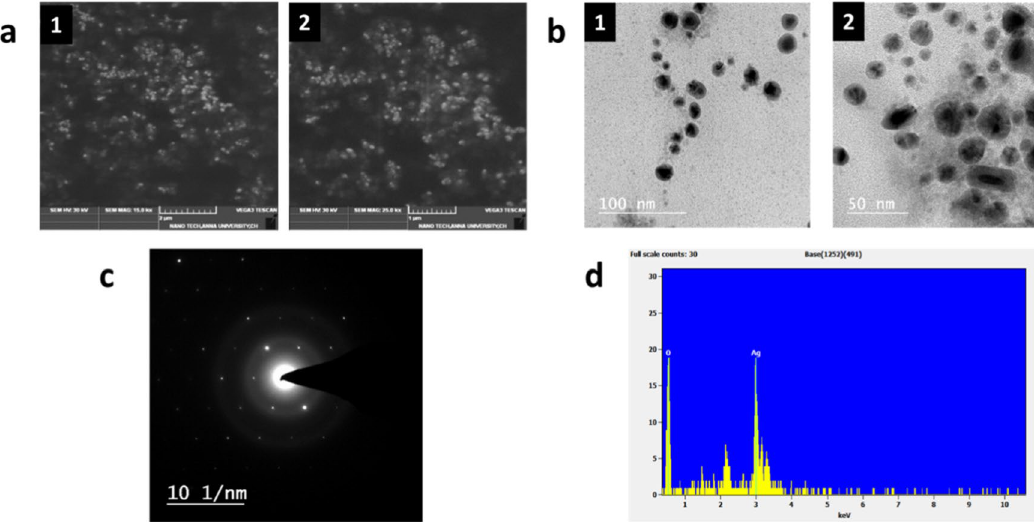
Figure 2. ( a ) SEM images of synthesized AgNPs (a1. 2 µm, a2.1 µm) ( b ) TEM images of synthesized AgNPs (b1. 100 nm, b2. 50 nm), ( c ) SAED pattern of synthesized AgNPs ( d ) EDAX spectrum of synthesized